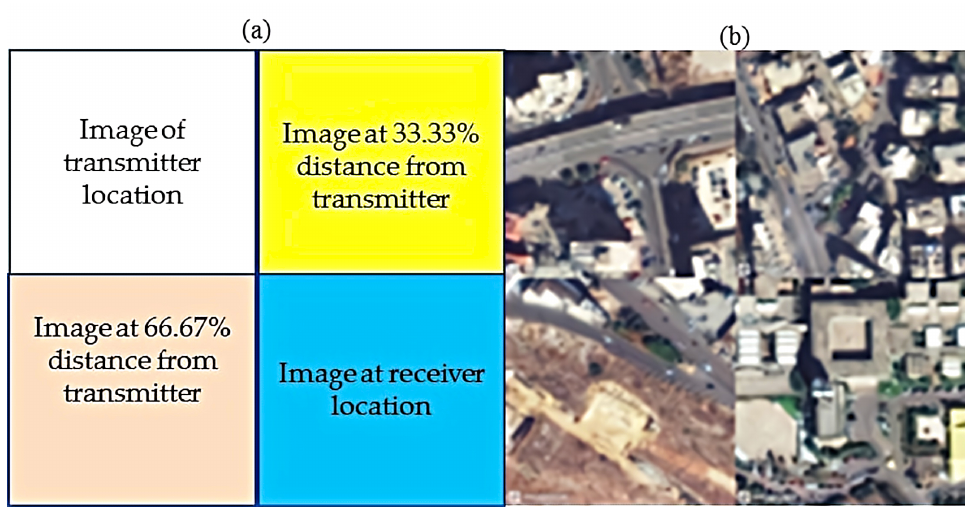
Figure 1. ( a ) Format of image concatenation. ( b ) Final concatenated image sample.